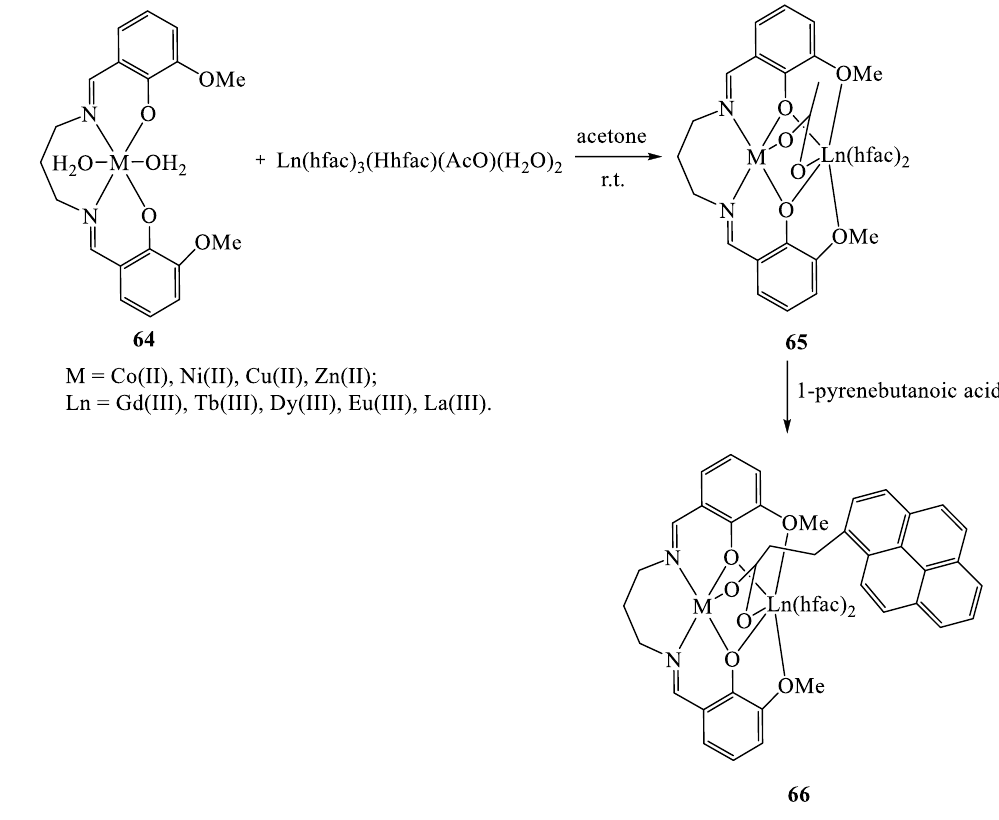
Figure 33. Molecular structure of 65 , 66 (dik = hfac) [103,104]. Hydrogen atoms have been omitted, some ligand groups are transparent for clarity. The cif has been retrieved from CCDC.